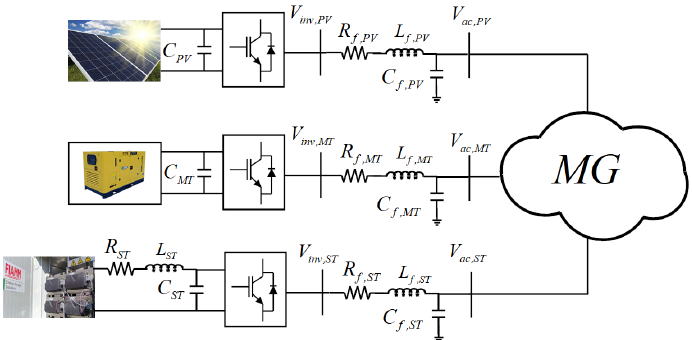
Figure 1. General